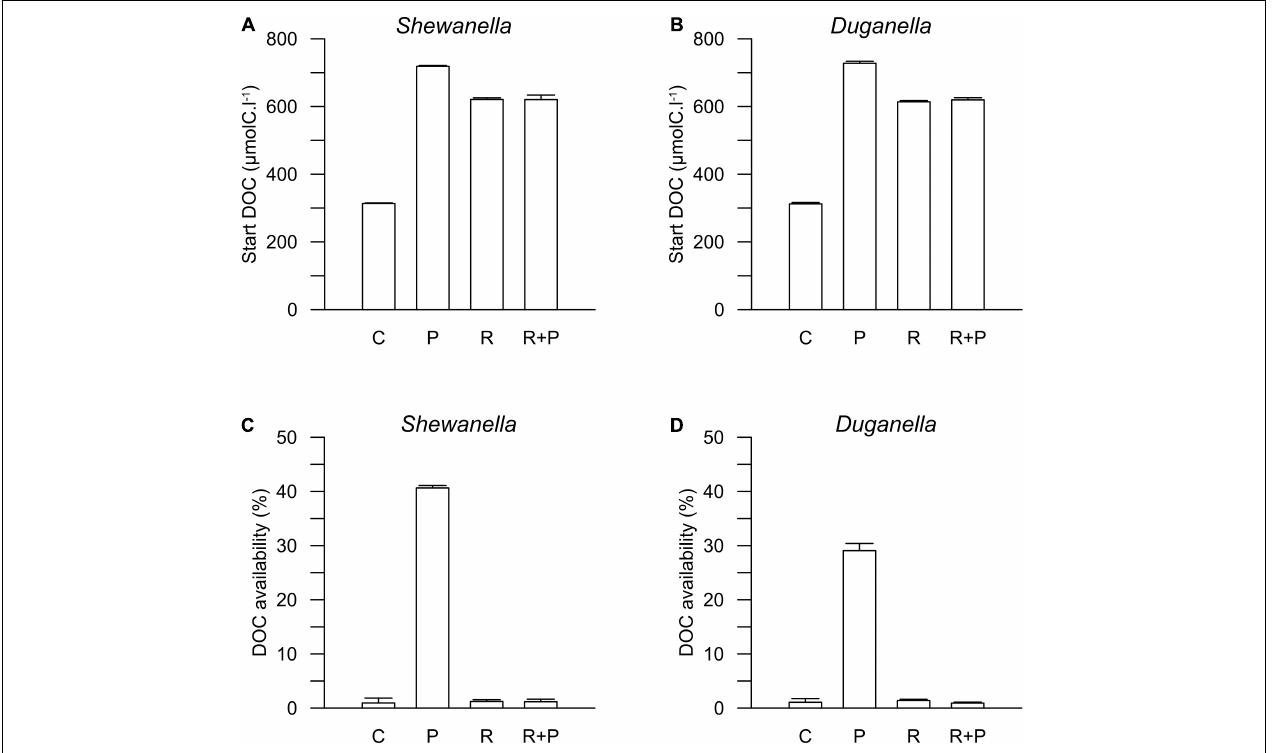
FIGURE 3 | Start concentration of DOC in (A) Shewanella and (B) Duganella incubations, and DOC availability in (C) Shewanella and (D) Duganella incubations. C = control; P = plankton extract; R = river extract; R + P = river extract supplemented with phosphorus. Bar graphs show average values, and error bars denote standard deviation.